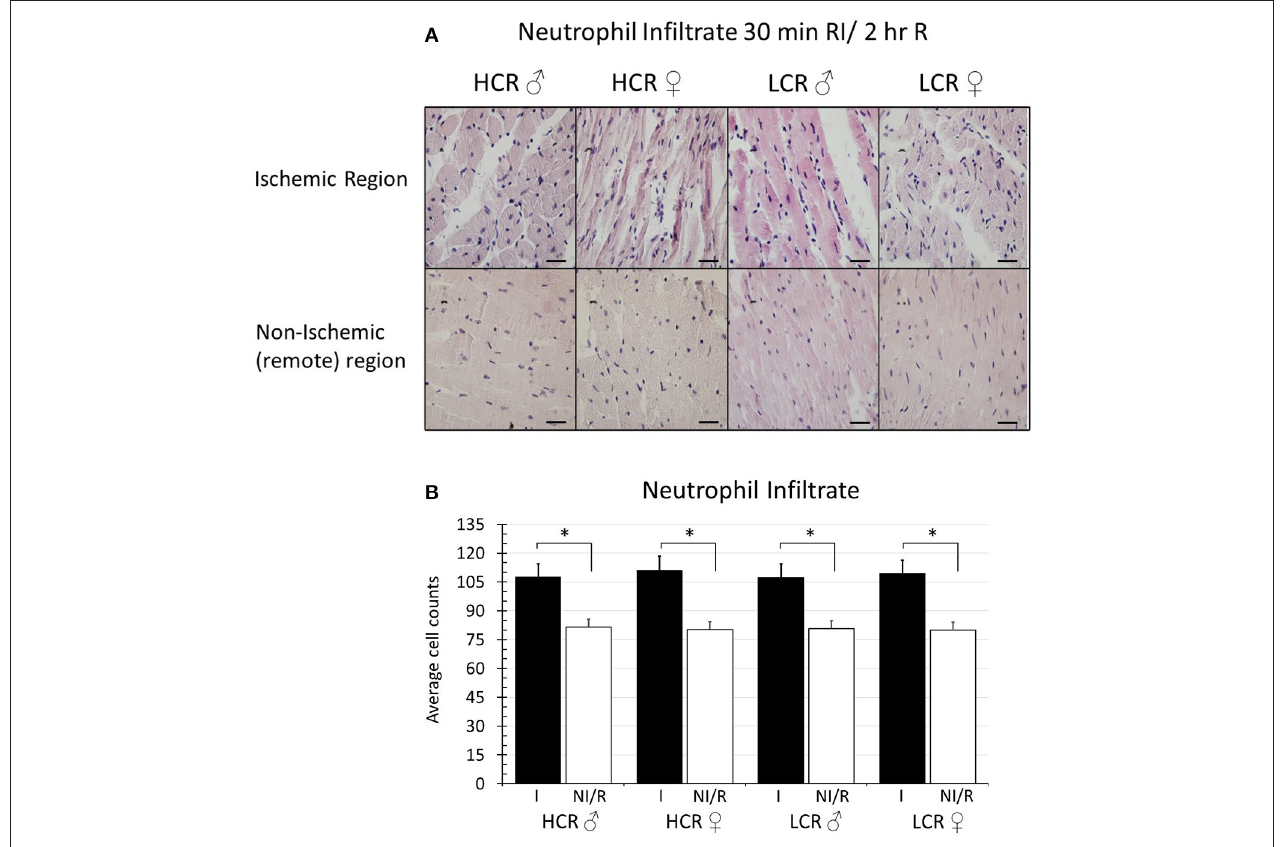
FIGURE 6 | (A) Sample histologic sections showing relative myocardial neutrophil infiltration after 30min in situ regional ischemia (RI) and 2h reperfusion by sex and by phenotype in samples from the ischemic region, and from non-ischemic, remote regions (right ventricle) from the same hearts (H&E staining, 60X). Scale bars in images represent 200 um. (B) Quantification of neutrophil infiltration (cell counts). Data represents average of 5 fields in each section, and 5 sections for each animal. Ischemic regions (I) showed higher levels of infiltration compared to non-ischemic remote (NI/R) regions, but the increased levels of infiltration were not different between sexes within either phenotype, and were not different between phenotypes for either sex (* p < 0.05 for the comparison indicated).